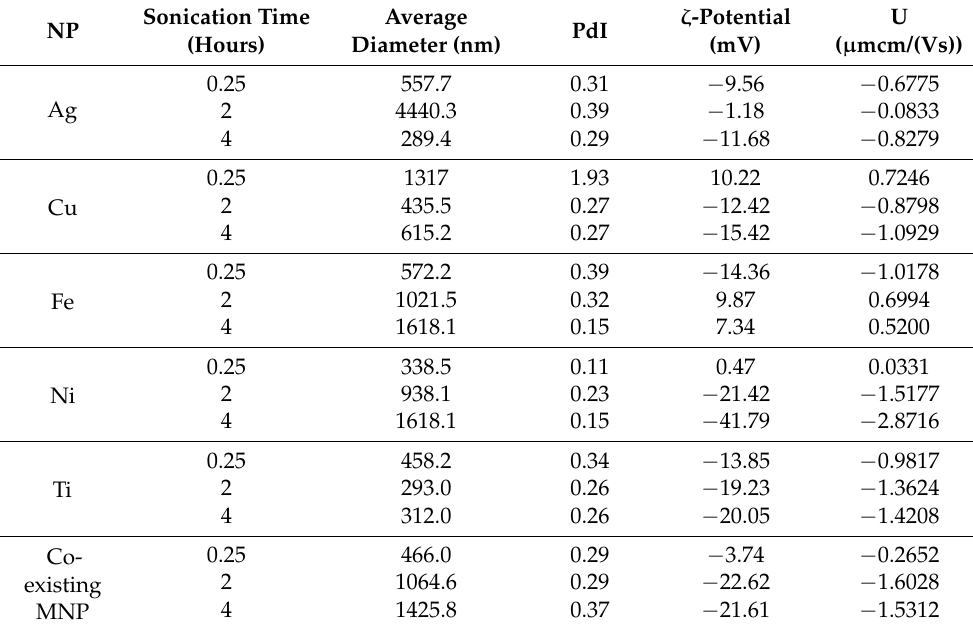
Figure 2. DLS size plots of the different NPs at various sonication times. ( a ) Ag NPs, ( b ) Cu NPs, ( c ) Fe NPs, ( d ) Ni NPs, ( e ) Ti NPs, and ( f ) co-existing MNP mix. Table 2. DLS measured characteristics of MNPs in the dispersion